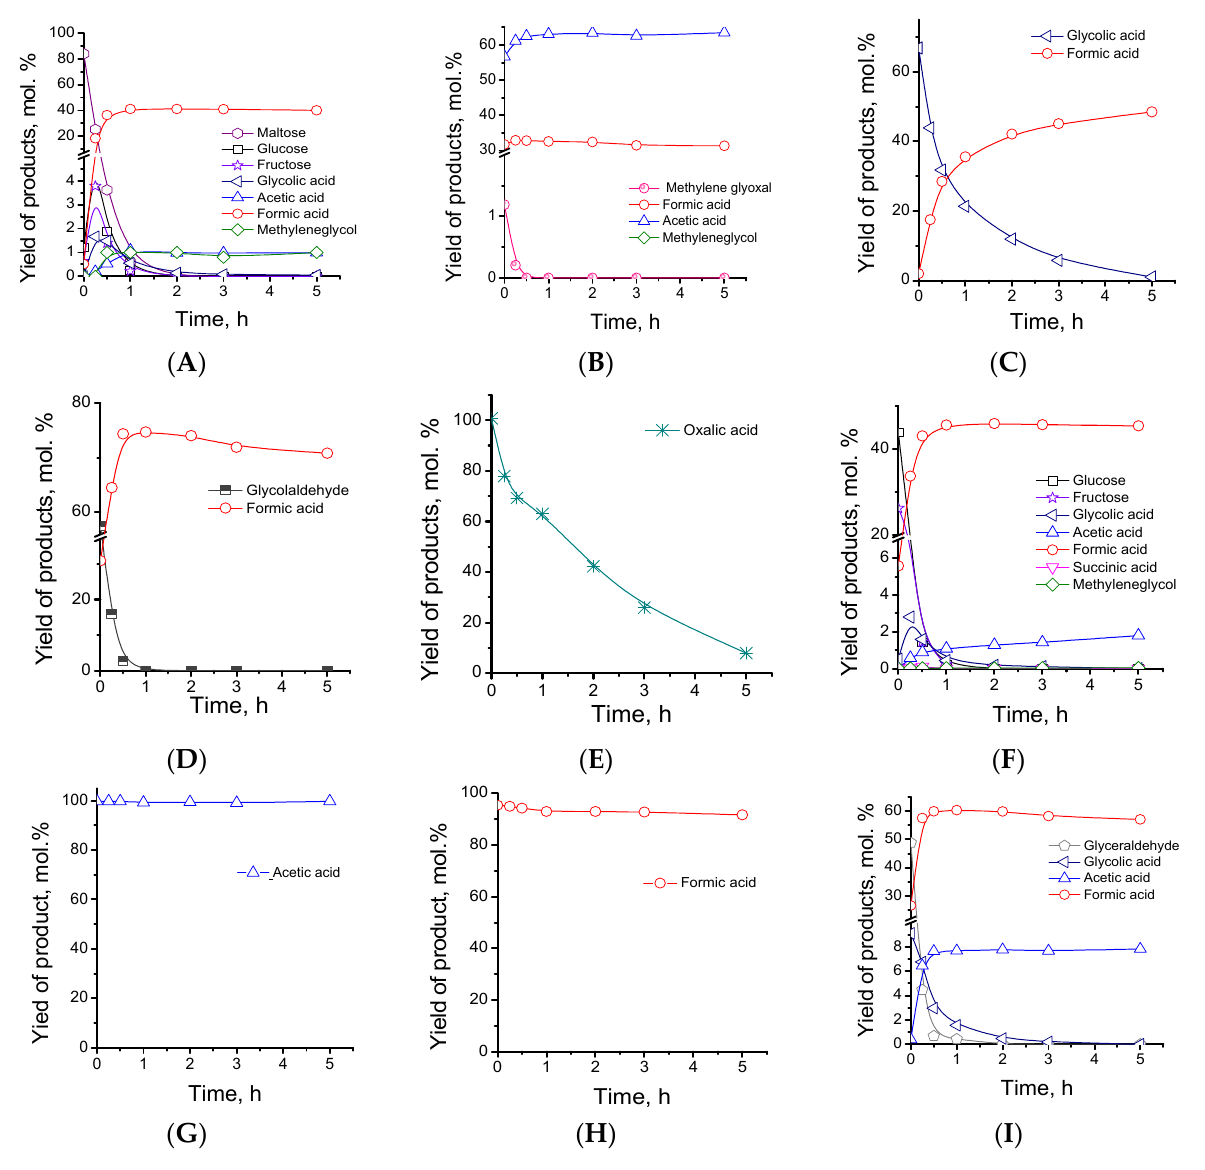
Figure 2. Kinetic curves of accumulation of water-soluble products during hydrolysis-oxidation of maltose ( A ) and oxidation of other reaction intermediates; transformation of methylglyoxal ( B ), glycolic acid ( C ), glycolaldehyde ( D ), oxalic acid ( E ), glucose ( F ), acetic acid ( G ), formic acid ( H ), glyceraldehyde ( I ) are shown. (Experimental conditions: 1.25 g/L of Et 4 N-PMoV, 108/1 of starch/catalyst molar ratio, 60 mL of the reaction volume, 2 MPa of air, 140 °C). Table 3. Constants of the starch hydrolysis-oxidation process.